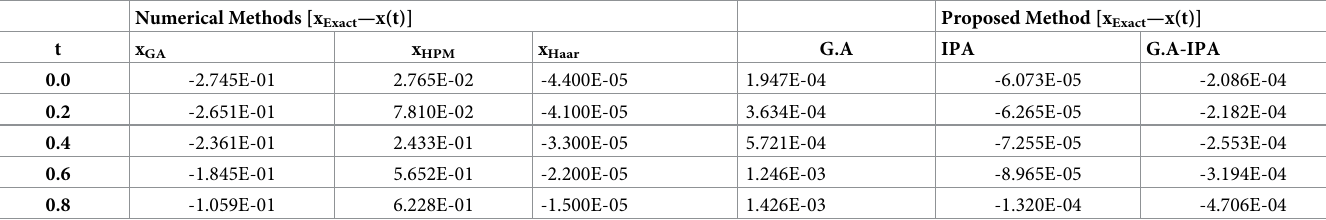
Table 8. Comparison of absolute errors between numerical methods and proposed method for δ = 2.0.